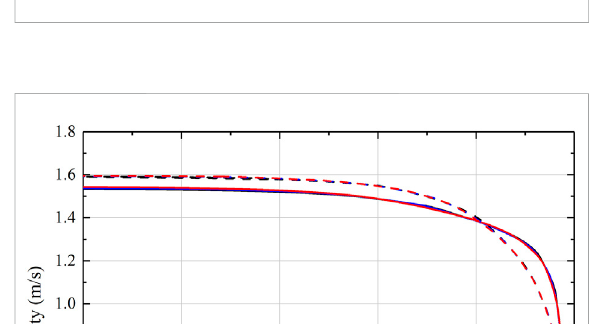
FIGURE 5 Sh / Sc 0.33 versus Re 0.5 for iron transfer on smooth wall ( Re from 5 × 10 3 to 10 5